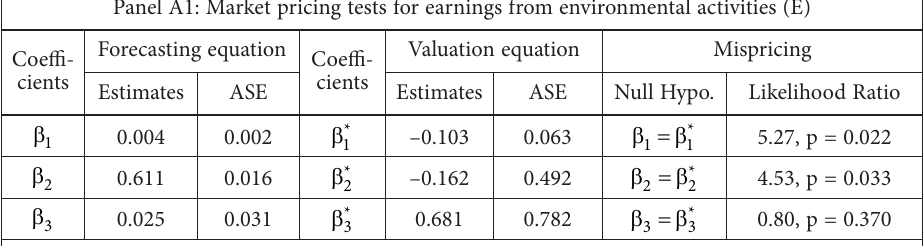
Table 9. Additional analysis of capital market reactions to sustainable management activities Panel A1: Market pricing tests for earnings from environmental activities (E) Coeffi-